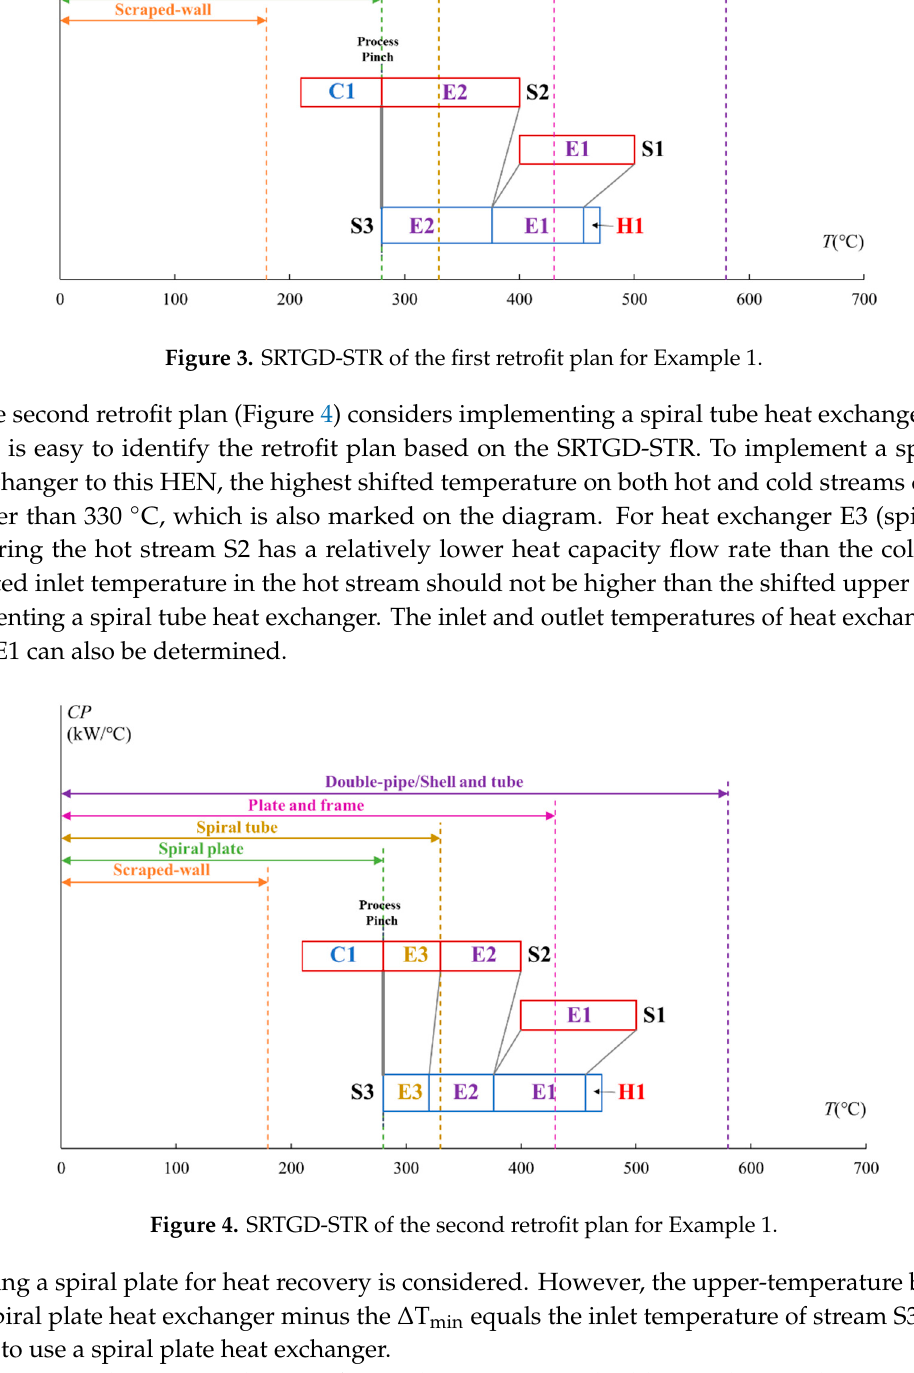
Figure 4. SRTGD-STR of the second retrofit plan for Example 1.